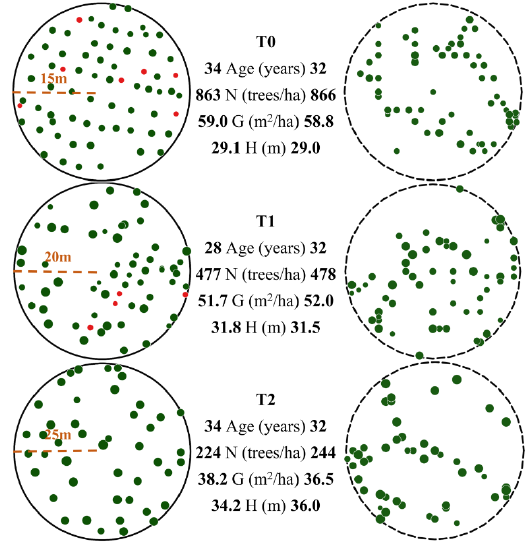
Figure 2. Examples of sample plots ( left ) and their matching virtual plots ( right ) in unthinned (T0), thinned once (T1), and thinned twice (T2) stands. The radius of each pair of plots was shown in the sample plot. The solid dots indicate the spatial locations of live (green) and dead (red) trees, while dot size is proportional to DBHOB. Stand attributes of the three pairs of plots are shown in the central text column. The clustered patterns of trees in the virtual plots reflect the harvester recorded spatial locations of harvested stems.